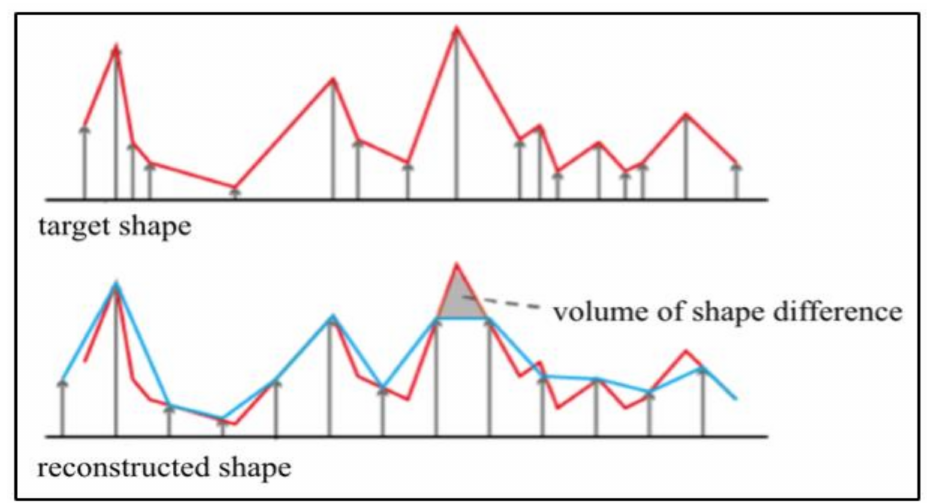
Figure 6. Shape difference between the target shape and reconstructed shape, used as a criterion to estimate the quality of result.